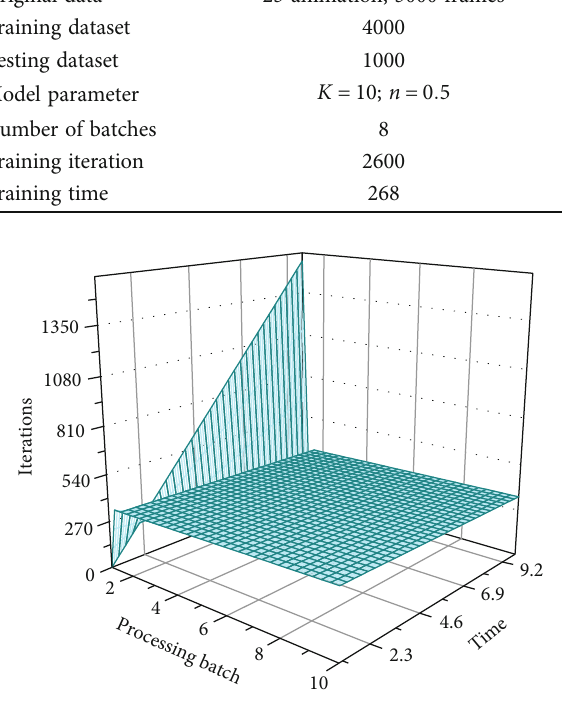
Figure 4: Number set 1 training result diagram.